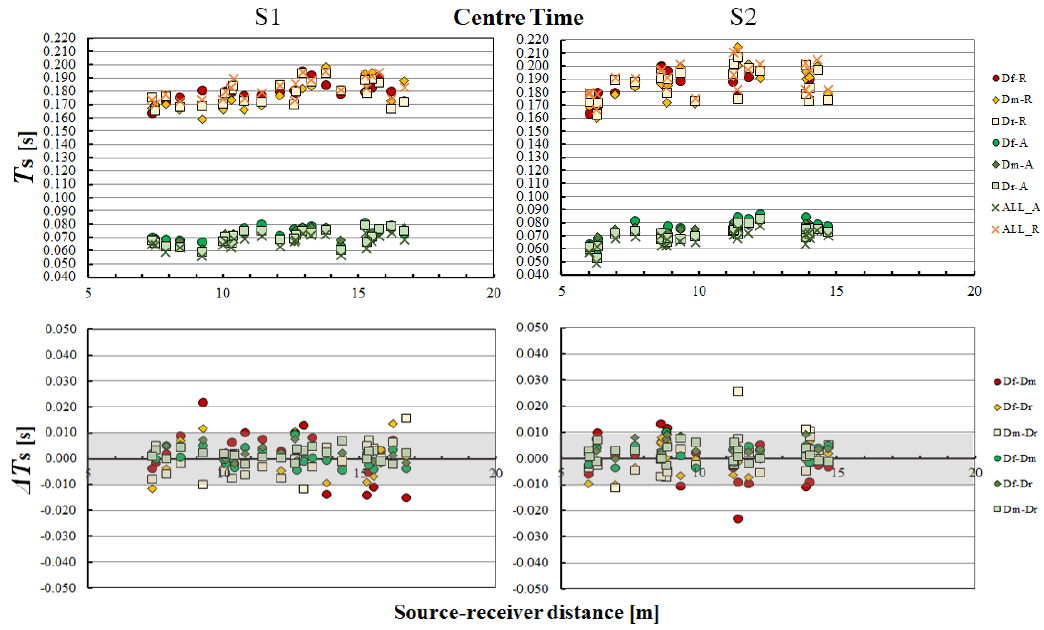
Figure 9. T s averaged over 500 Hz and 1000 Hz for S1 and S2 source-to-receiver distance. Δ T s represent the parameter differences between the configurations Df-Dm, Df-Dr, Dm-Dr in the reflective (-R) and absorptive (-A) conditions. Differences equal ±1 JND of the parameters are highlighted through a gray area.